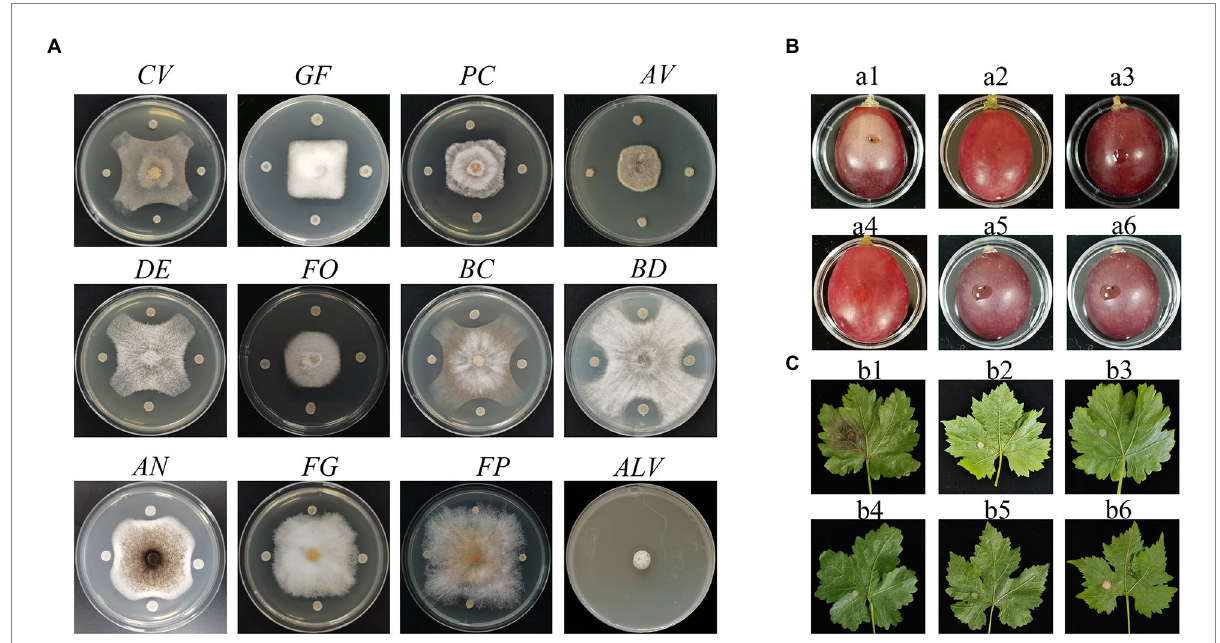
FIGURE 1 Antagonistic assay of Paenibacillus peoriae ZBSF16 against eleven pathogenic fungi and one pathogenic bacterium. (A) Antagonistic assay of P. peoriae ZBSF16. Coniella vitis (CV). Gloeosporium fructigrum (GF). Pestalotiopsis clavispora (Pc). Alternaria viticola (Av). Diaporthe eres (DE). Fusarium oxysporum (FO). Botrytis cinerea (BC) . Botryosphaeria dothidea (BD). Aspergillus niger (AN). Fusarium graminearum (FG). Fusarium pseudograminearum (FP). Allorhizobium vitis (ALV). (B,C) Biocontrol efficiency of P. peoriae ZBSF16 on grape white rot caused by Coniella vitis . (a1, b1) Inoculated with C. vitis ; (a2, b2) LB broth; (a3, b3) sterile water; (a4, b4) culture of ZBSF16; (a5, b5) inoculated with C. vitis 24 h after inoculation with the culture of ZBSF16; (a6, b6) inoculated culture of ZBSF16 24 h after inoculation with C. vitis